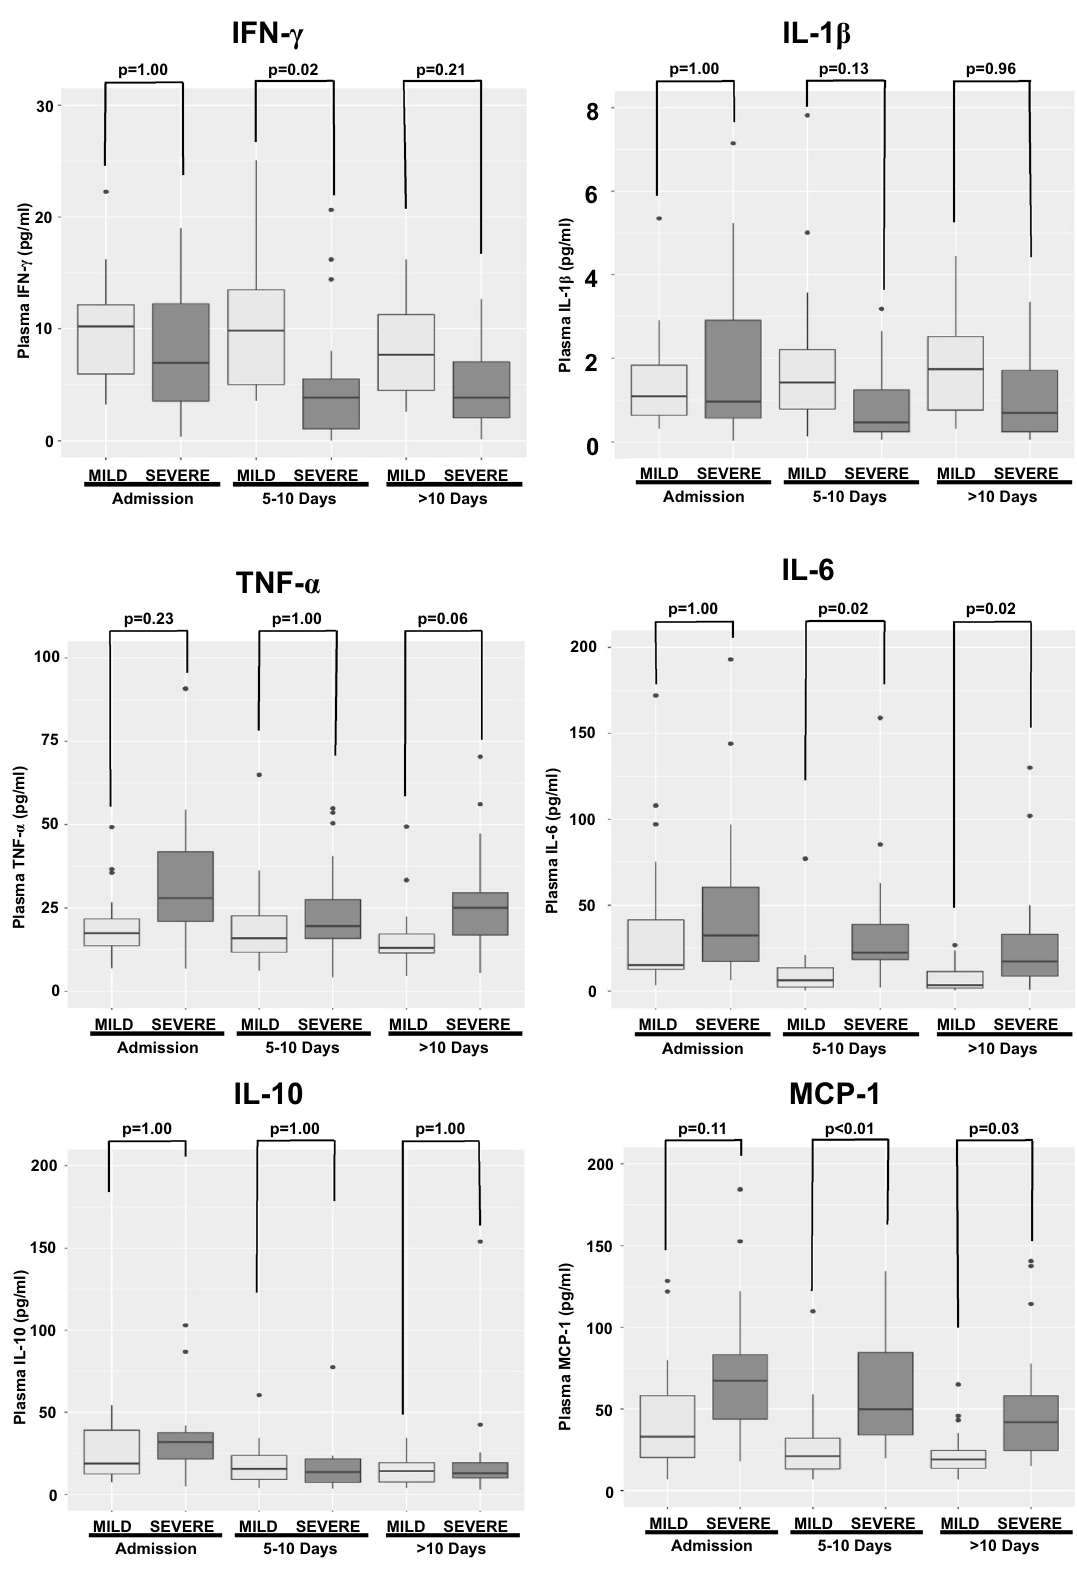
Figure 6. Serum cytokine levels during hospitalization. Circulating cytokines in plasma from the COVID-19 patients was also measured, and the profile was similar to that observed for mRNA. IFN-γ was lower in the SEVERE COVID-19 group (N = 50 patients) when compared to COVID-19 MILD (N = 29 patients), while pro-inflammatory cytokine levels (IL-6, TNF-α, and MCP-1) were higher. P values were calculated using the nonparametric Kruskal–Wallis test in R software (version 4.0.3 for